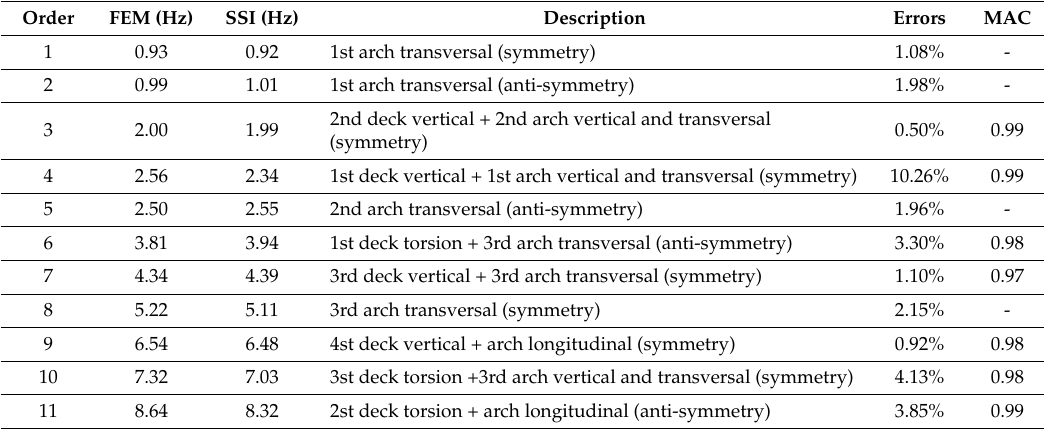
Table 1. Results of the numerical simulation and modal